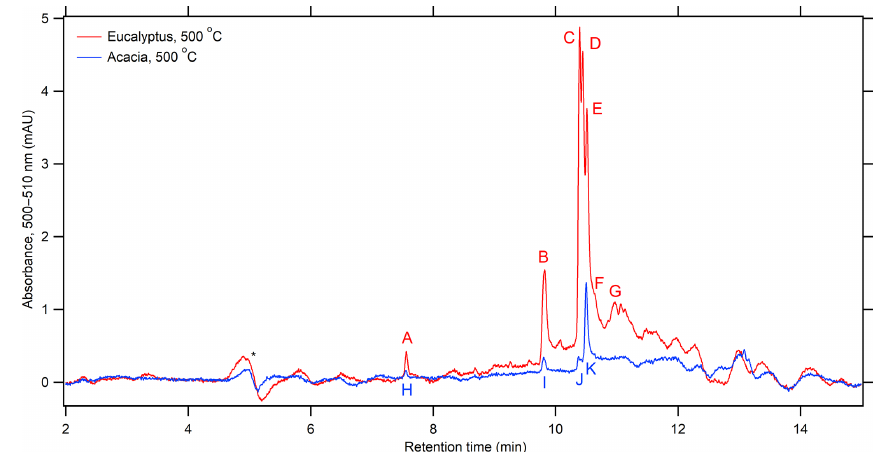
Figure 6. The extracted wavelength chromatogram for the 500–510nm region for each fuel freshly combusted at 500 ◦ C. The peak with the asterisk is an artifact from background